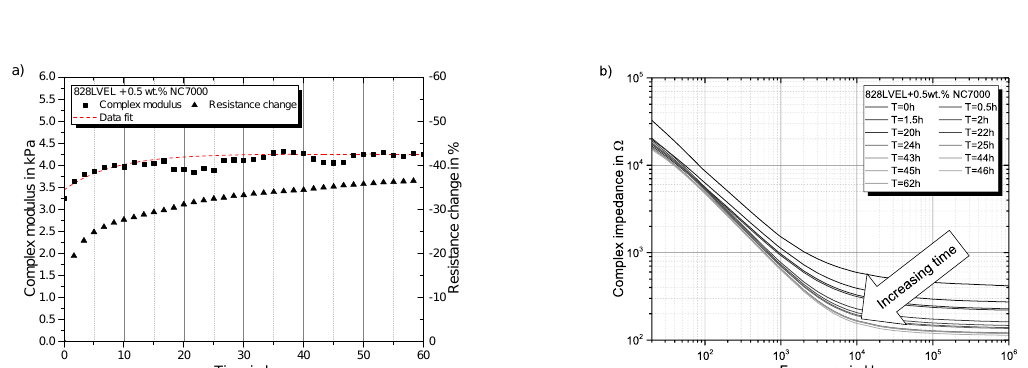
Figure 5. Change of ( a ) complex modulus and electrical resistance in oscillation and ( b ) complex impedance over